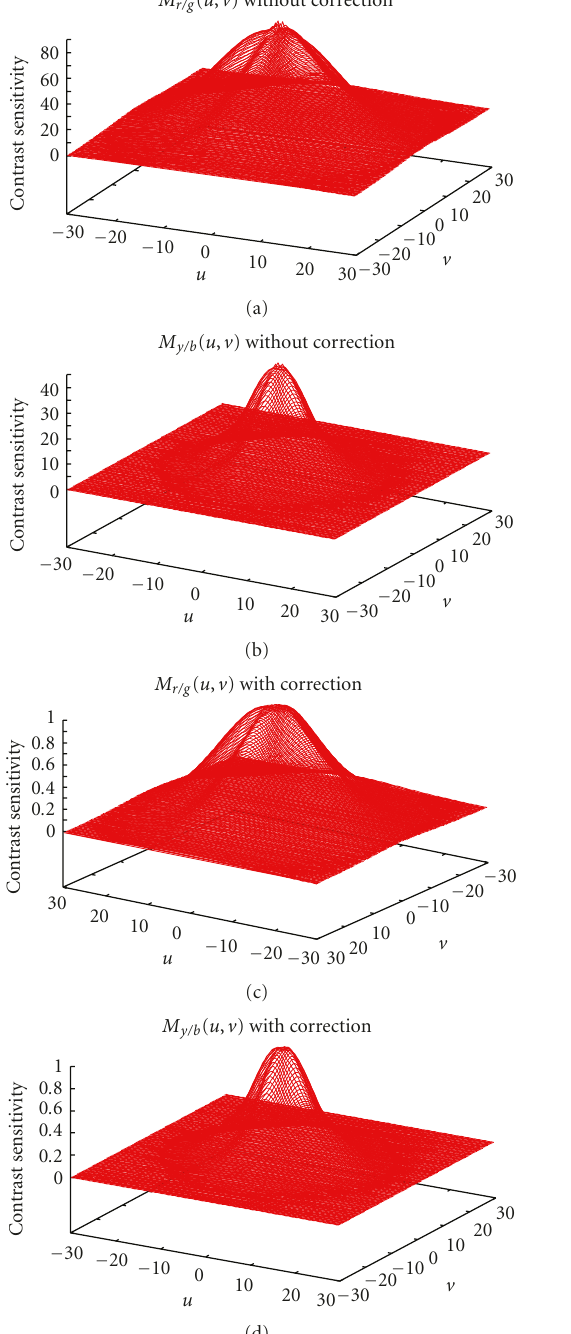
Figure 4: Shapes of M r/g ( u , v ) and M y/b ( u , v ).